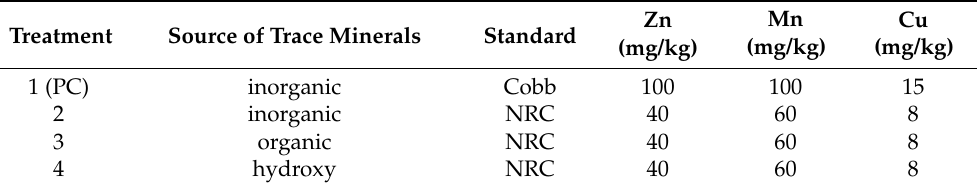
Table 2. Sources and supplementary levels of trace minerals fed in the broiler starter (0–12 days), grower (13–24), and finisher (25–35 days)